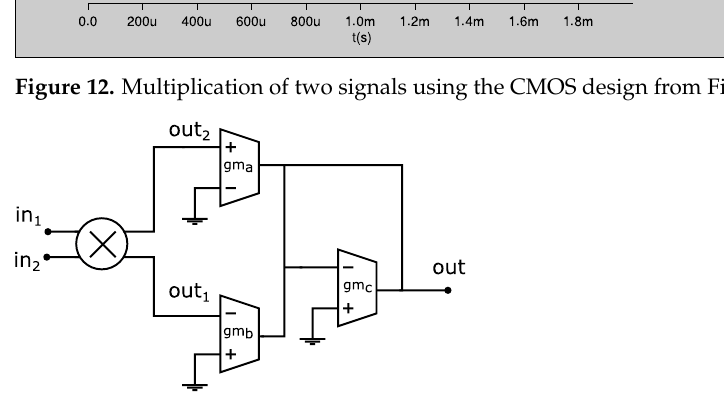
Figure 13. Proposed single-ended multiplier combining the fully-differential multiplier shown in Figure 11 and an